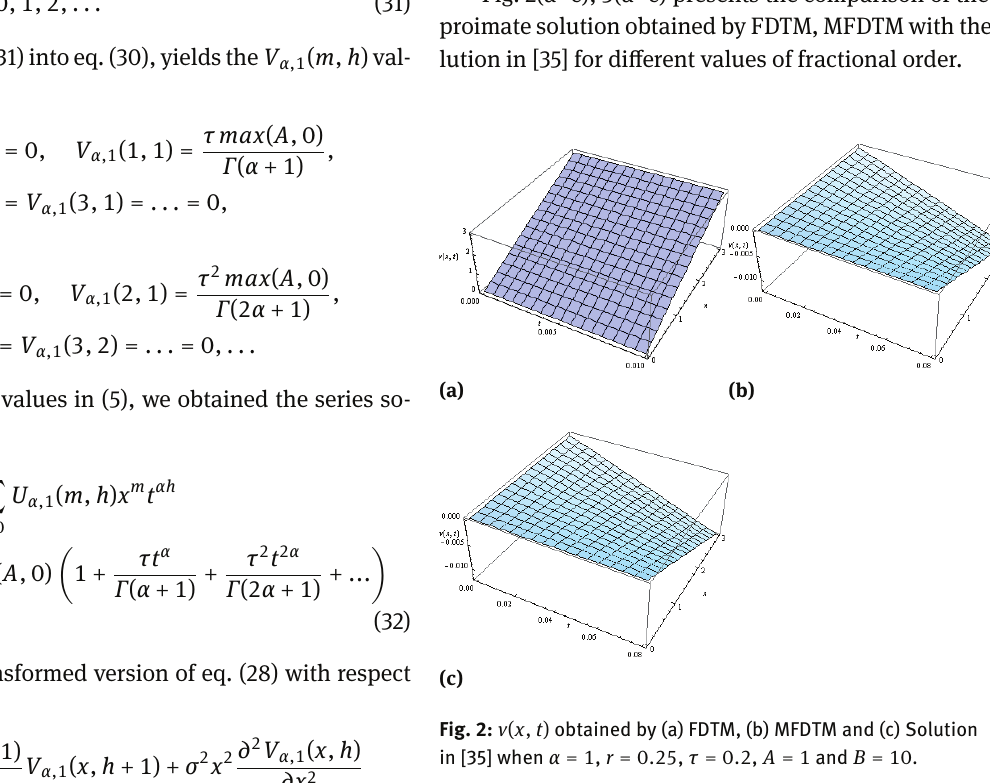
Fig. 2: v ( x , t ) obtained by (a) FDTM, (b) MFDTM and (c) Solution in [35] when α = 1 , r = 0.25 , τ = 0.2 , A = 1 and B = 10